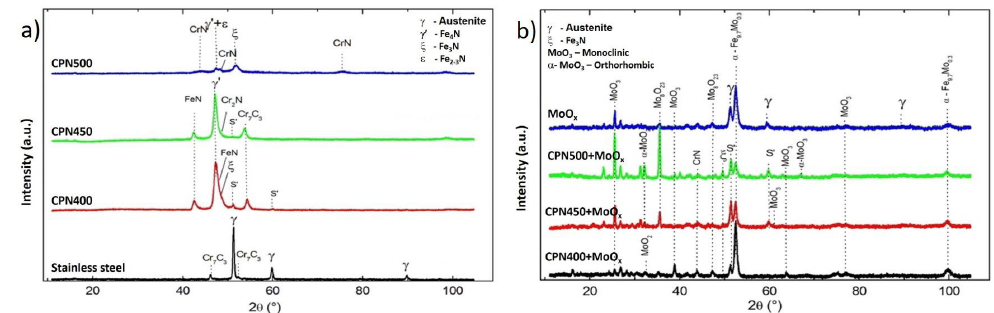
Figure 4. X-ray diffractograms after (a) nitriding and (b) nitriding + MoO